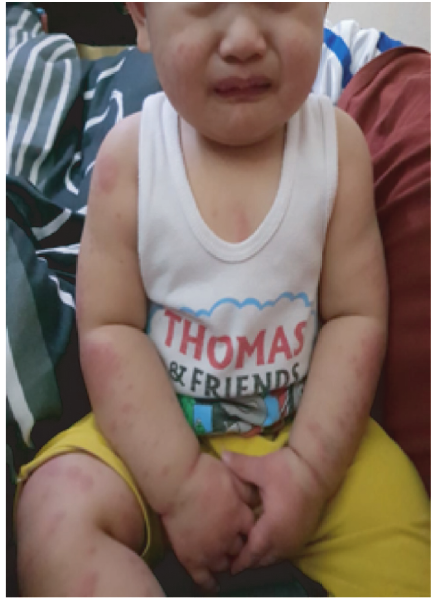
Figure 2: Rash over the entire body.